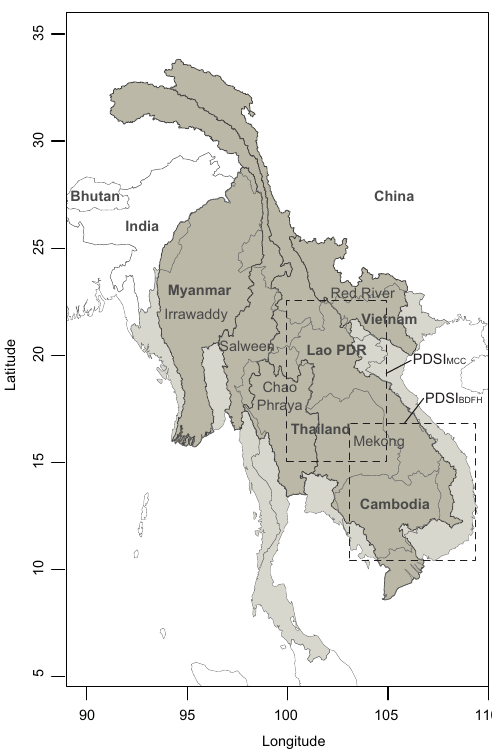
Figure 1. Map of the study area: mainland Southeast Asia. The spa- tial variability of ENSO’s influence was analysed using annual pre- cipitation data over the period of 1980–2013 with a focus on the area covering Myanmar, Thailand, Lao PDR, Vietnam, and Cambodia and the largest river basins: the Irrawaddy, Salween, Chao Phraya, Mekong, and Red rivers. The temporal variability of ENSO’s in- fluence was analysed using proxy Palmer drought severity index (PDSI) data for the March–May season over the period of 1650– 2004 with a focus on two regions shown in the figure with rectan- gles denoting the PDSI MCC and PDSI BDFH reconstruction fields of Sano et al. (2008) and Buckley et al. (2010),